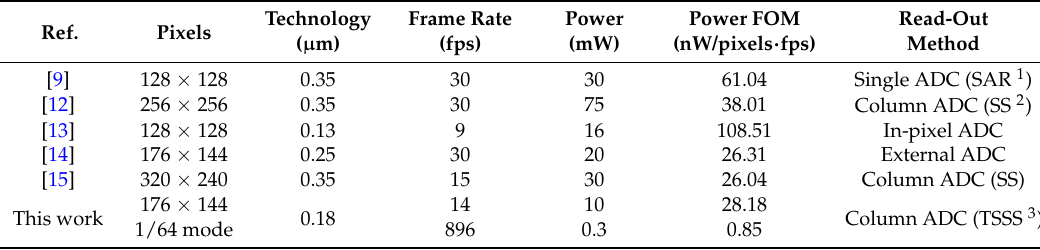
Table 2. Performance comparison of the proposed CIS (figure of merit: